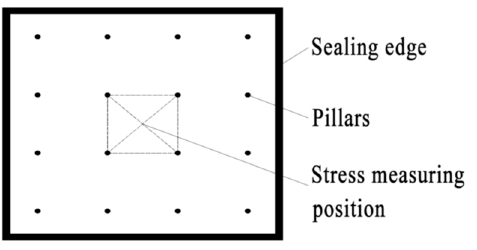
Figure 1. Schematic of a stress measuring position. Table 2. Surface stress evaluation basis.